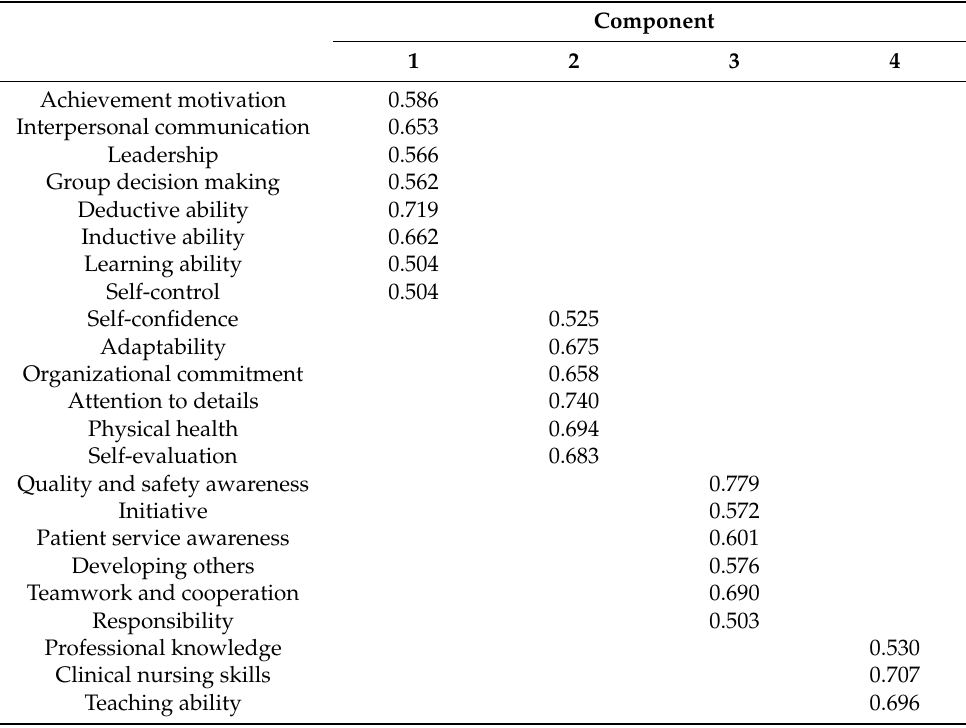
Table 3. Loading table for competency elements after